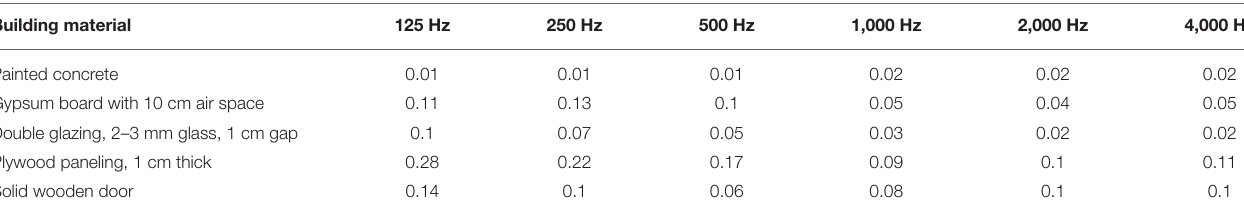
TABLE 2 | Sound absorption coefficients of building structures used to predict reverberation time through Sabine’s theory (Cox and d’Antonio,